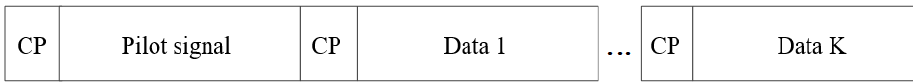
Figure 2 indicates: SS1 is the first subscriber station, SS2 is the second subscriber station, BS is the base station. In the developed model is studied influence of the error in estimating transfer function of the radio channel. Also studied the error in estimating frequency shift on the probability of a bit error during signal